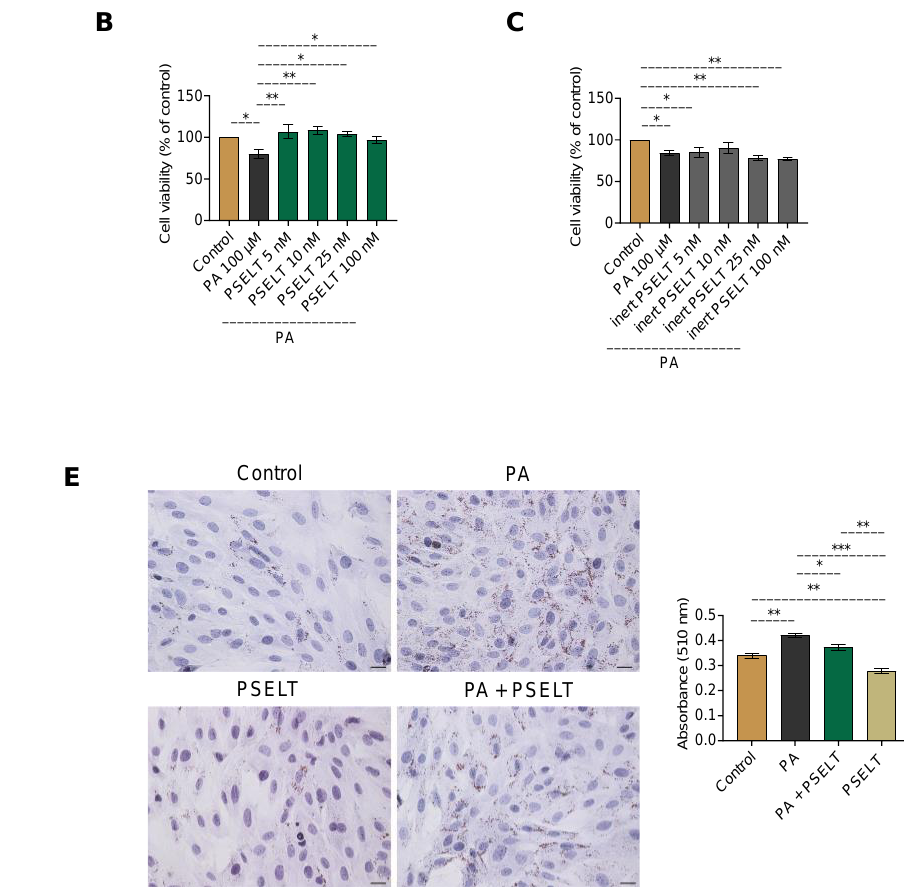
Figure 1. Effects of palmitate (PA) with or without PSELT on cell viability, cytotoxicity, and lipid accumulation in H9c2 cardiomyocytes. H9c2 cells were exposed to vehicle (Control) or increasing concentrations of ( A ) PA (100–500 µmol/L) or ( B ) PA 100 µmol/L + PSELT (5–100 nmol/L) or ( C ) PA 100 µmol/L + inert PSELT (I-PSELT) (5–100 nmol/L) for 24 h. The viability of H9c2 cells was determined using MTT assay and was expressed as the percentage of control cells. Results are reported as the mean ± SEM ( n = 6 per group). Significant differences were detected by one-way ANOVA followed by Dunnett’s test, p < 0.05 (*); p < 0.01 (**); and p < 0.0001 (****) vs. the Control group. ( D ) Lactate dehydrogenase (LDH) release in the culture medium of H9c2 cardiomyocytes treated with vehicle, PA (100 µmol/L) and PSELT (5 nmol/L) alone or in co-treatment for 24 h. The LDH activity is expressed as IU/L. Data are shown as the mean ± SEM of six separate experiments. Significant differences were detected by one-way ANOVA and Newman-Keuls multiple comparison test, p < 0.05 (*); p < 0.01 (**); and p < 0.0001 (****). ( E ) Representative images of Oil Red O staining for lipid droplet assessment and relative quantification. H9c2 cardiomyocytes treated with vehicle (Control), PA 100 µmol/L, PA + PSELT 5 nmol/L or PSELT for 24 h. Scale bar: 25 µm. Quantification of the stained lipid droplets was performed by measuring the absorbance at 510 nm. Values are the mean ± SEM of three different experiments. p < 0.05 (*); p < 0.01 (**); p < 0.001 (***); and p < 0.0001 (****).